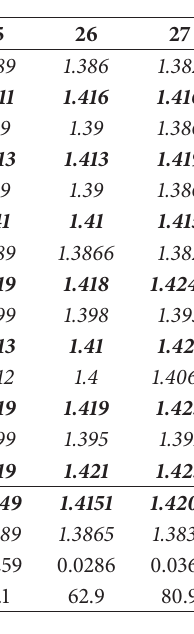
Table 3: Bond fixation in DHPN and % aromaticity of heteroarenes calculated through geometric